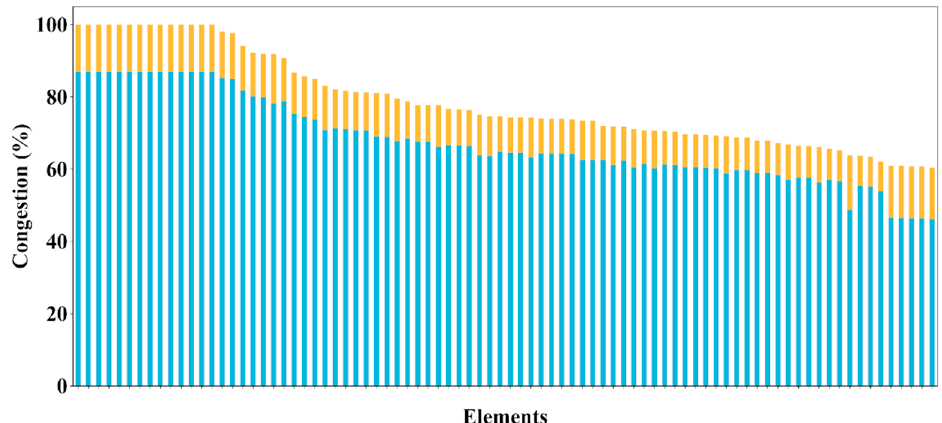
Figure 13. Maximum congestion measured (in orange) and optimal congestion threshold assigned (in blue) in the most saturated elements in the case study. Table 8. Threshold ratios and time characteristics of the cluster centers.